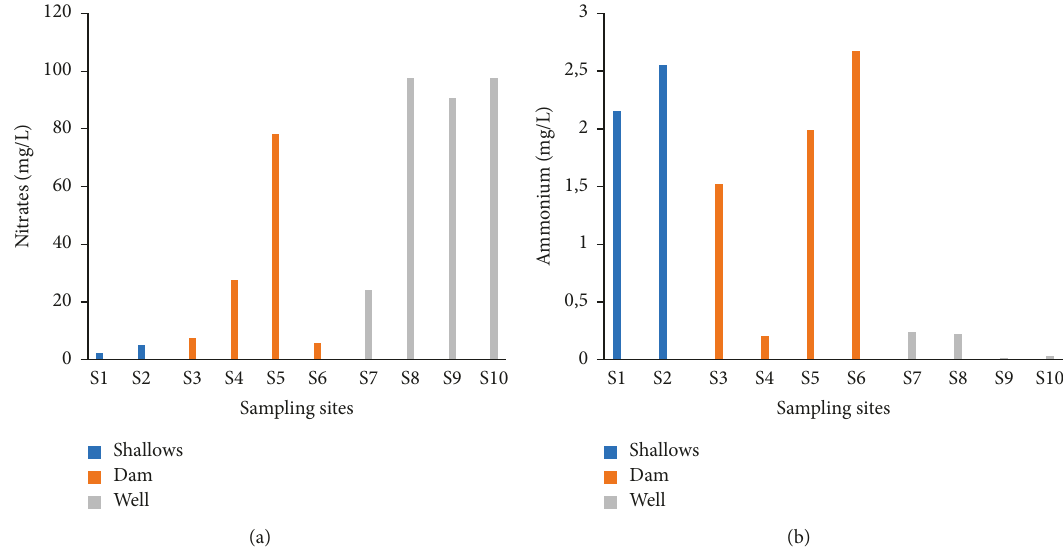
Figure 9: Nitrate (a) and ammonium (b) concentrations in irrigation